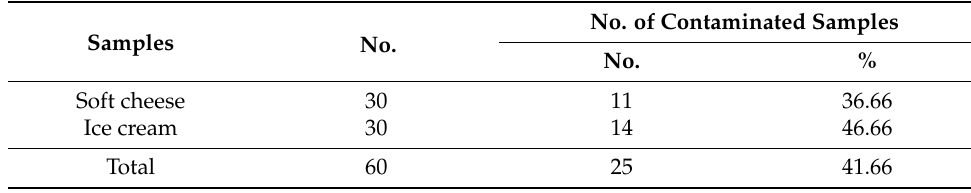
Table 1. Listeria spp. in the examined soft cheese and ice cream